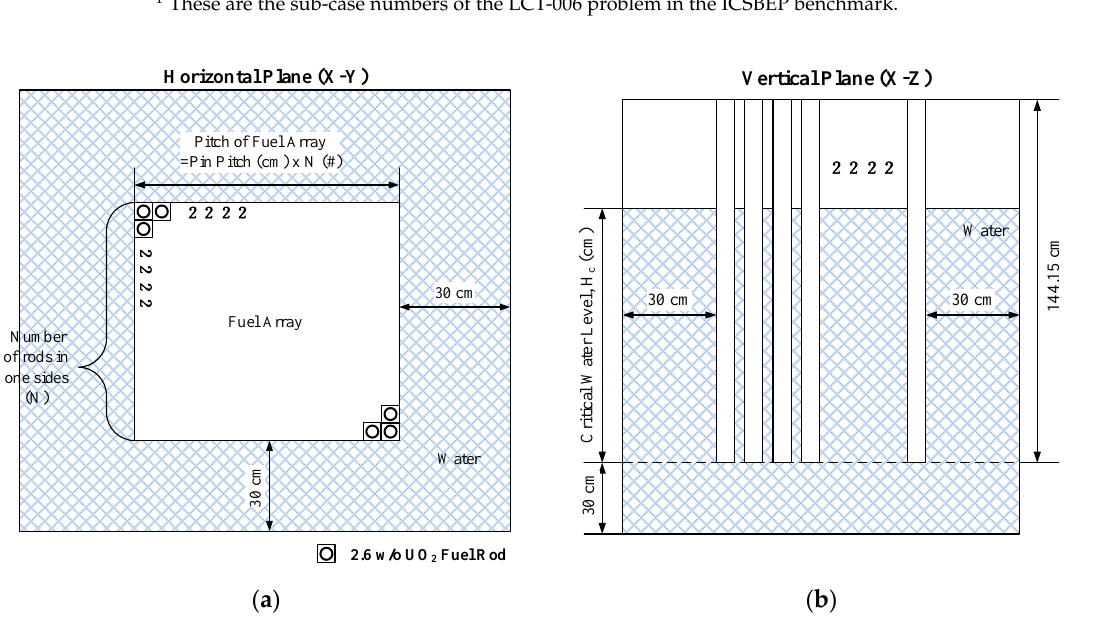
Figure 2. ( a ) Horizontal cross section of a lattice core in the TCA Benchmark Problems; ( b ) vertical cross section of a lattice core in the TCA Benchmark Problems.